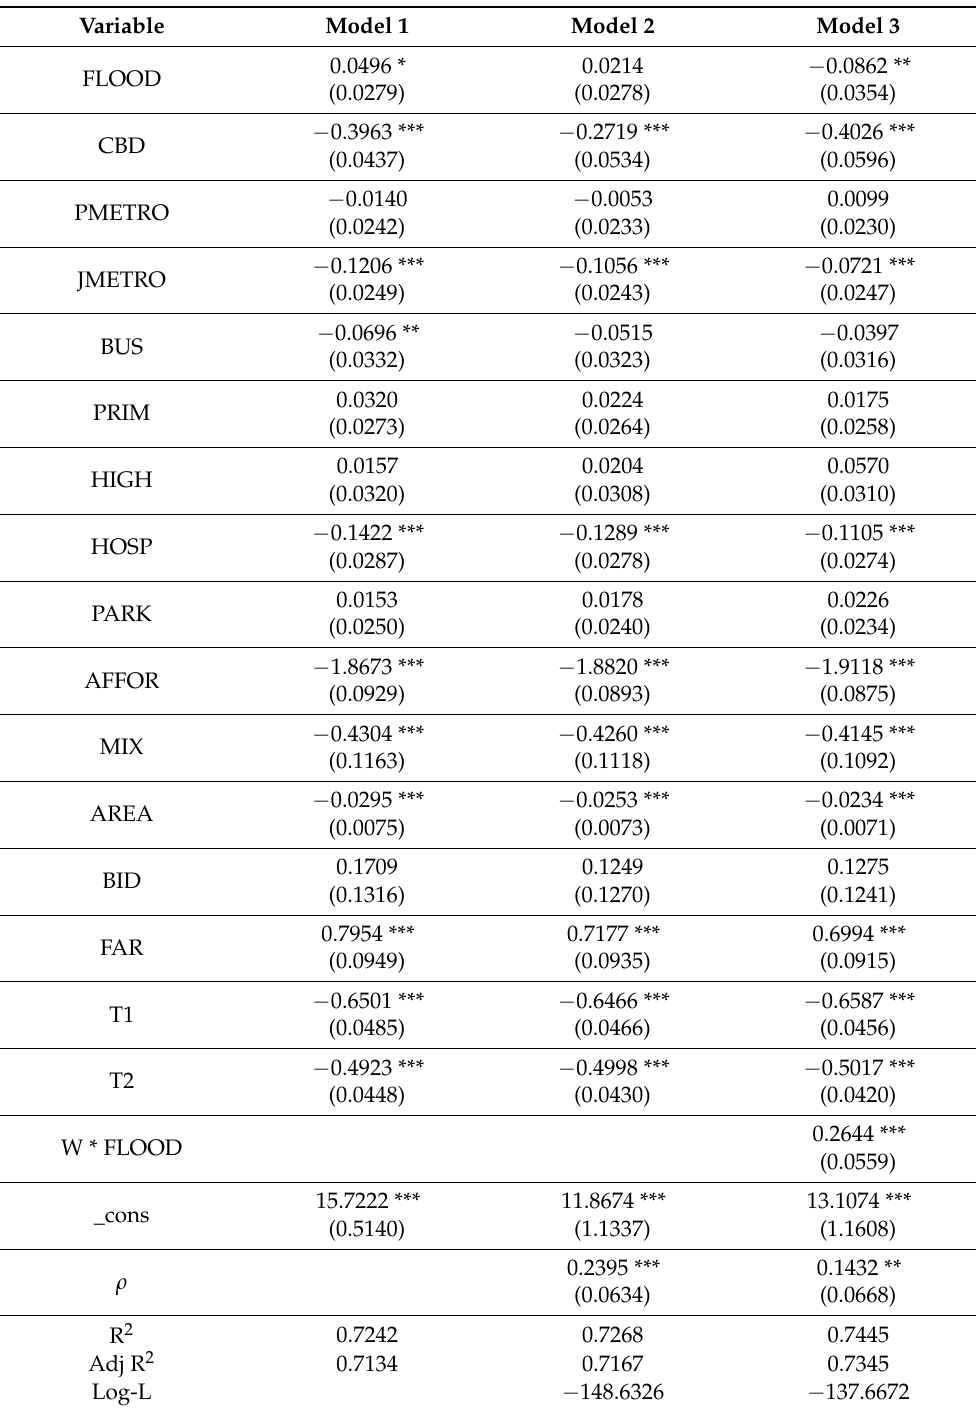
Table 6. Estimation results of the spatial Durbin